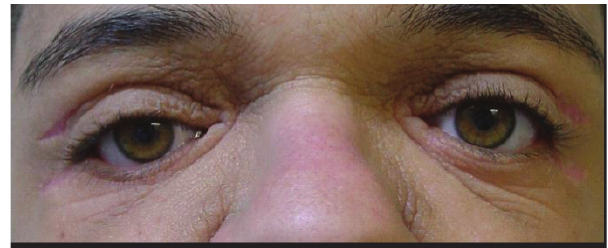
Figure 3 - Final results after 1 year. Lateral canthal suspension provided a better lower eyelid position because it pulled and suspended its components, and it especially stabilized the lower eyelid with the orbit